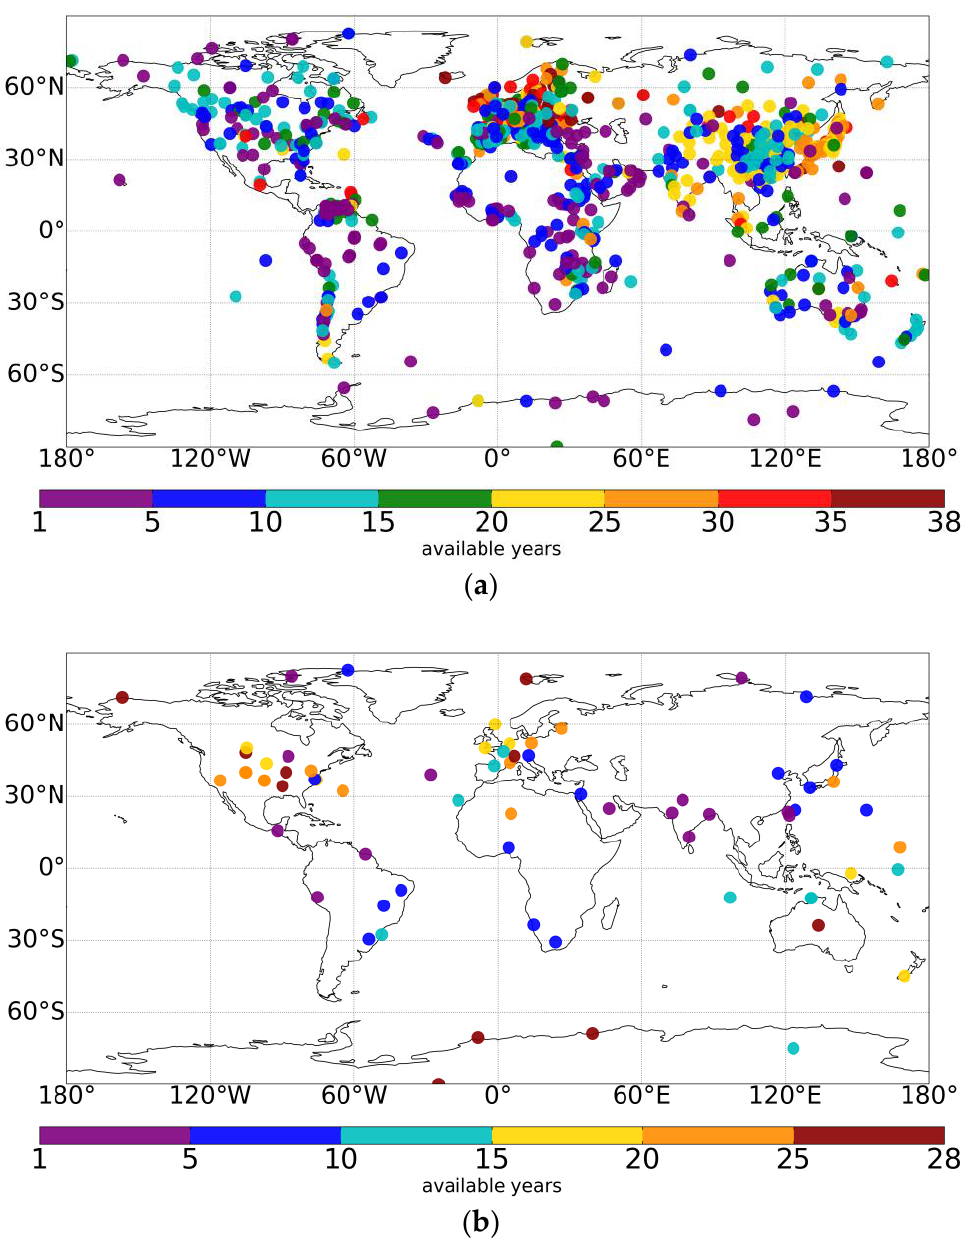
Figure 1. Global Distribution of: ( a ) Global Energy Balance Archive (GEBA) 1099 stations and ( b ) Baseline Surface Radiation Network (BSRN) 70 stations, whose surface solar radiation (SSR) data (availability in years indicated in the colorbar) have been used in this study.